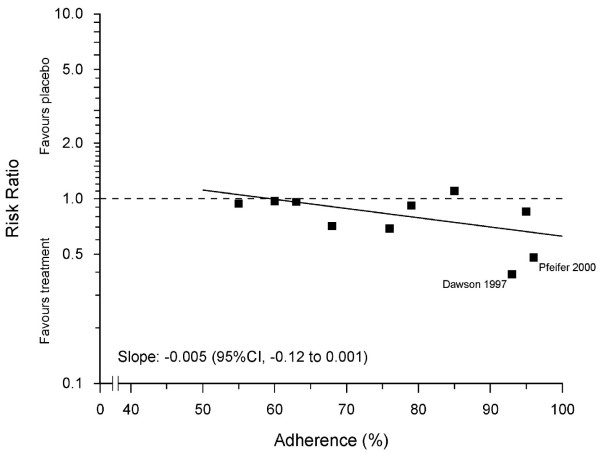
Risk ratios for any nonvertebral fracture according to adherence to the trial medication. Slope: slope of the regression line. 95%CI: 95 percent confidence interval. Pearson correlation coefficient: -0.56 (p = 0.10).